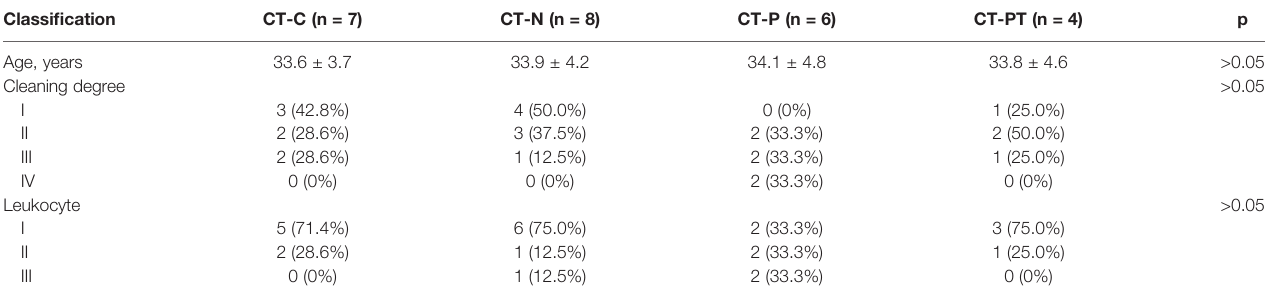
CT-C, healthy women with C. trachomatis-negative from the PEC; CT-N, infertile women with C. trachomatis-negative from the ART; CT-P, infertile women with C. trachomatis-positive from the ART; CT-PT, CT-P women post-treatment with azithromycin; ART, assisted reproductive technology center; PEC, physical examination